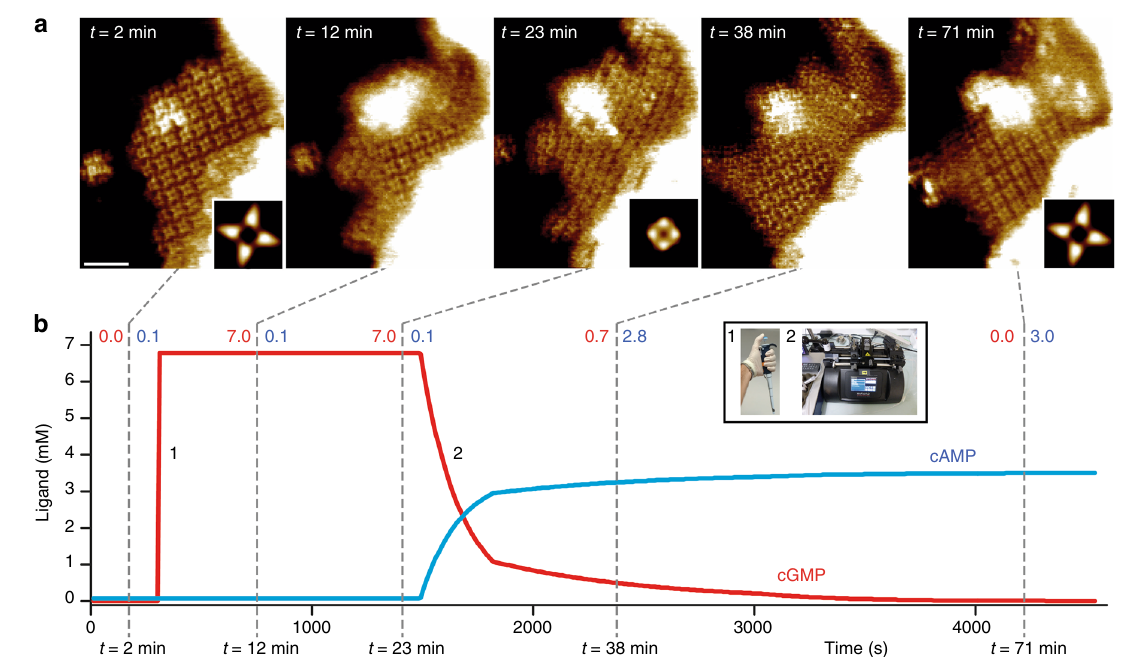
Fig. 4 Reversibility of cyclic nucleotide-dependent conformational changes. a HS-AFM time-lapse high-resolution image sequence showing CNBD conformational and 2D-lattice rearrangement dynamics of SthK upon cGMP injection (panels t = 12 min and t = 23 min) and after controlled cGMP removal and cAMP re-addition via a fl uid exchange pumping system (panels t = 38 min and t = 71 min). Insets in t = 2 min, t = 23 min and t = 71 min are correlation averages ( n = 22, n = 39, and n = 17 tetramers) of the corresponding frames. The molecular conformational changes lead to local membrane bending (bright area in the top part of the membrane). Scale bar: 30 nm. b cAMP (blue) and cGMP (red) concentrations as a function of time during the HS-AFM experiment. Dashed lines and adjacent labels indicate the times (bottom) and the cAMP (blue) / cGMP (red) concentrations when the images shown on top were acquired. Inset displays cGMP addition through pipetting (1) and cAMP buffer exchange